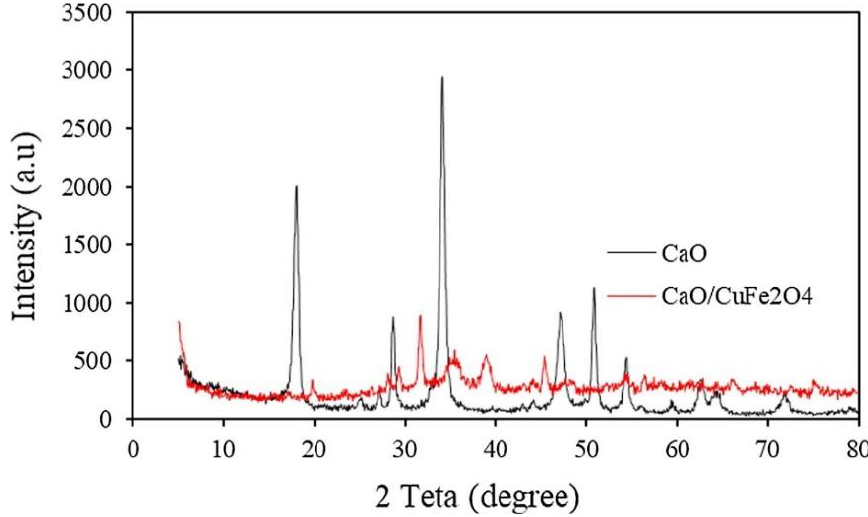
Figure 7. XRD spectrum of the nanocatalyst CaO and CaO/CuFe 2 O 4 . Reprinted with permission from Ref. [83]. 2022, Elsevier.